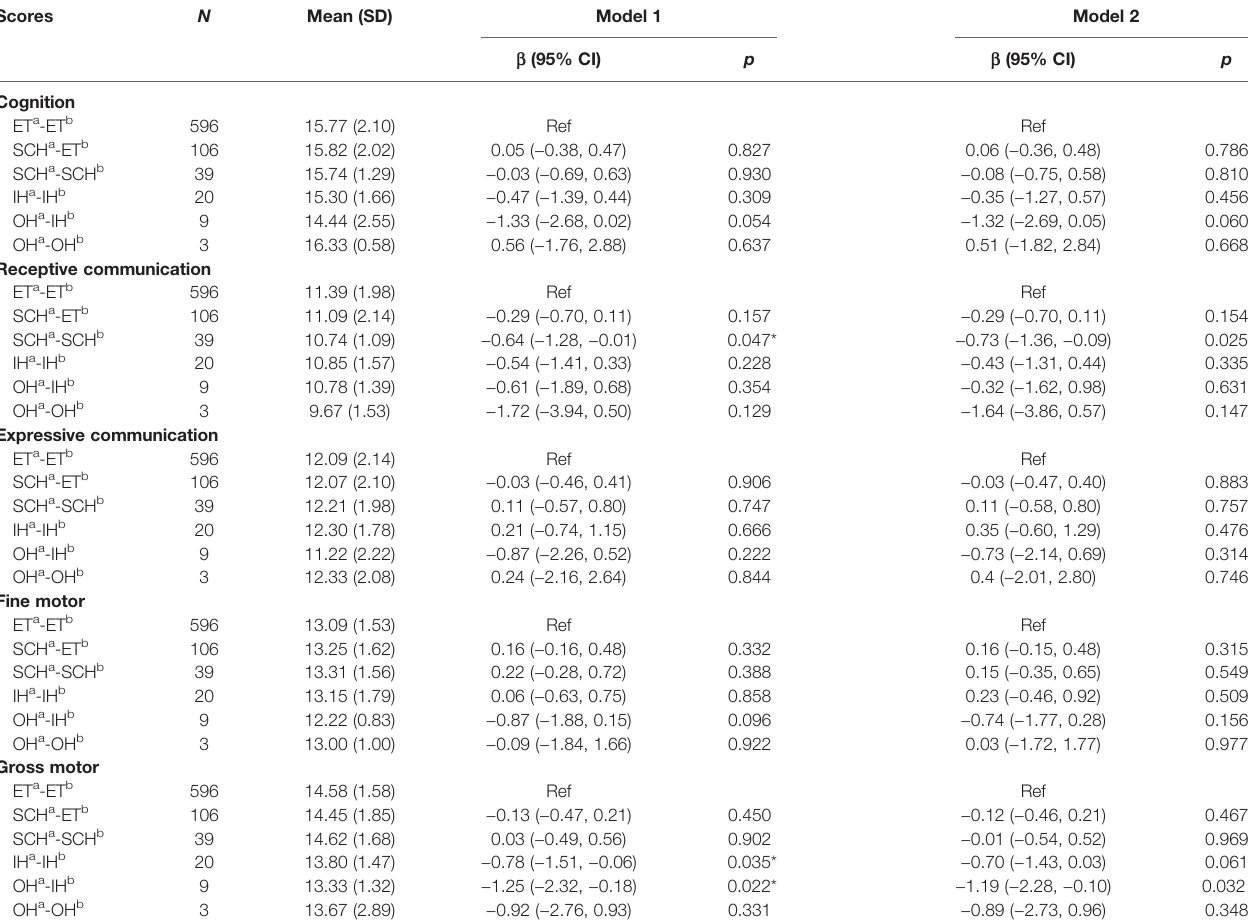
TABLE 3 | Multivariable regression analysis to demonstrate the association of maternal TSH with infant Bayley-III scores. Scores N Mean